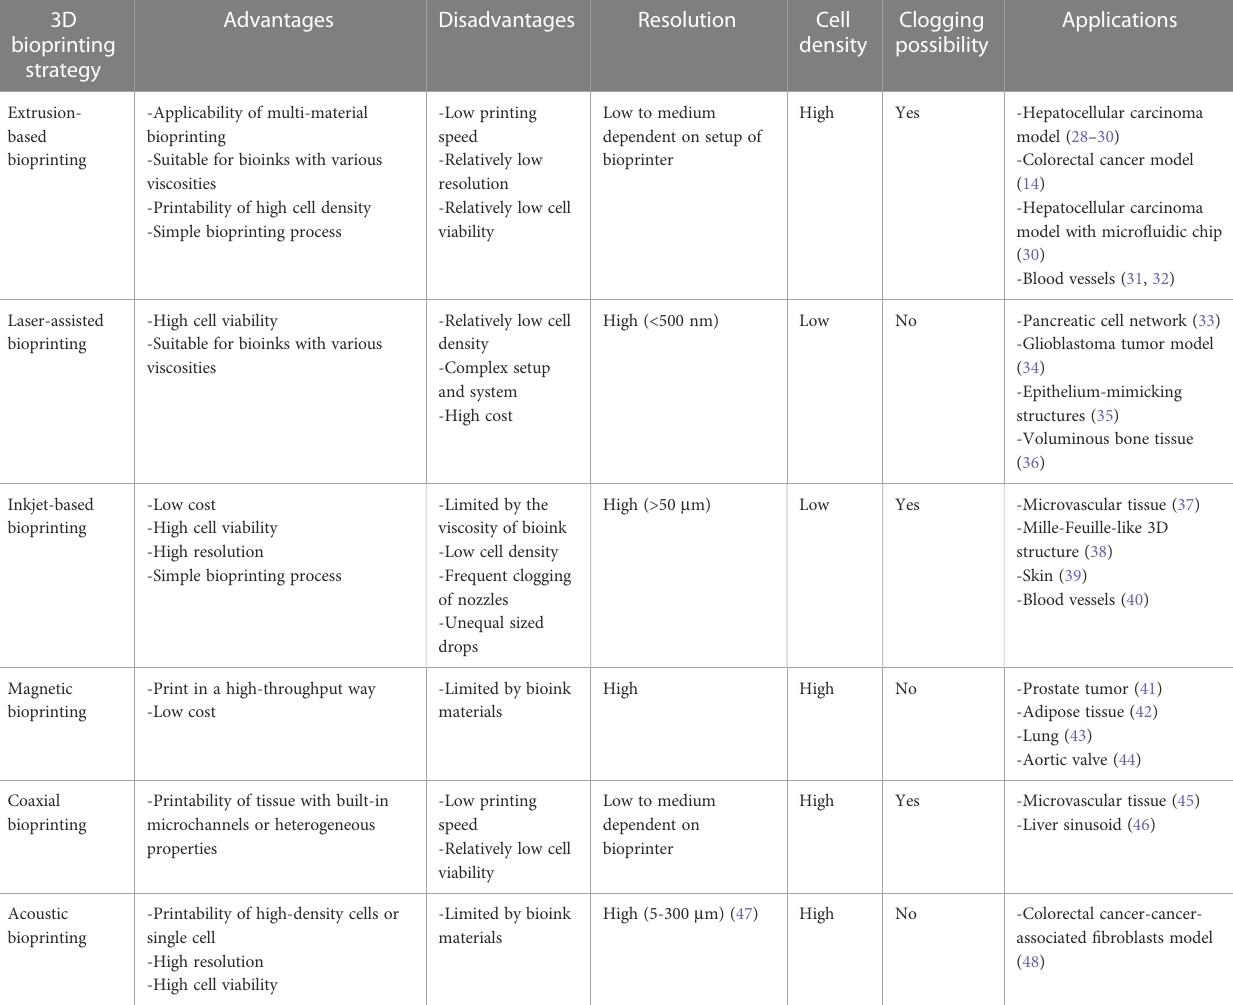
TABLE 1 Features and applications of different strategies of 3D